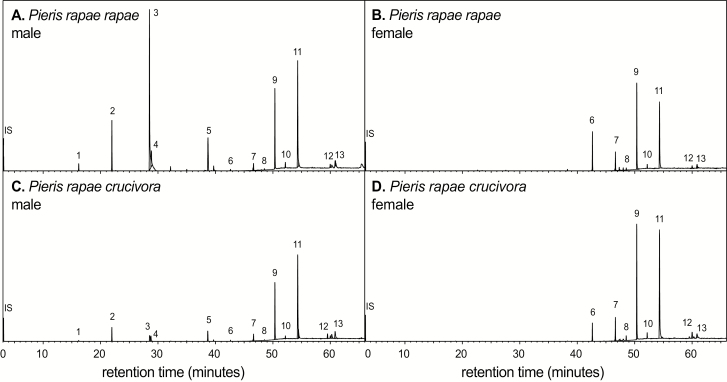
Typical chromatograms from wing extracts of single individuals. (A) Pieris rapae rapae male. (B) P. r. rapae female, C. P. r. crucivora male, D. P. r. crucivora female. Compound identities are as follows: (1) Indole, (2) Ferrulactone, (3) hexahydrofarnecyl acetone, (4) Phytol derivative, (5) Phytol, (6) Tricosane, (7) Pentacosane, (8) Hexacosane, (9) Heptacosane, (10) Octacosane, (11) Nonacosane, (12) Hentriacontane, (13) Cholesterol.